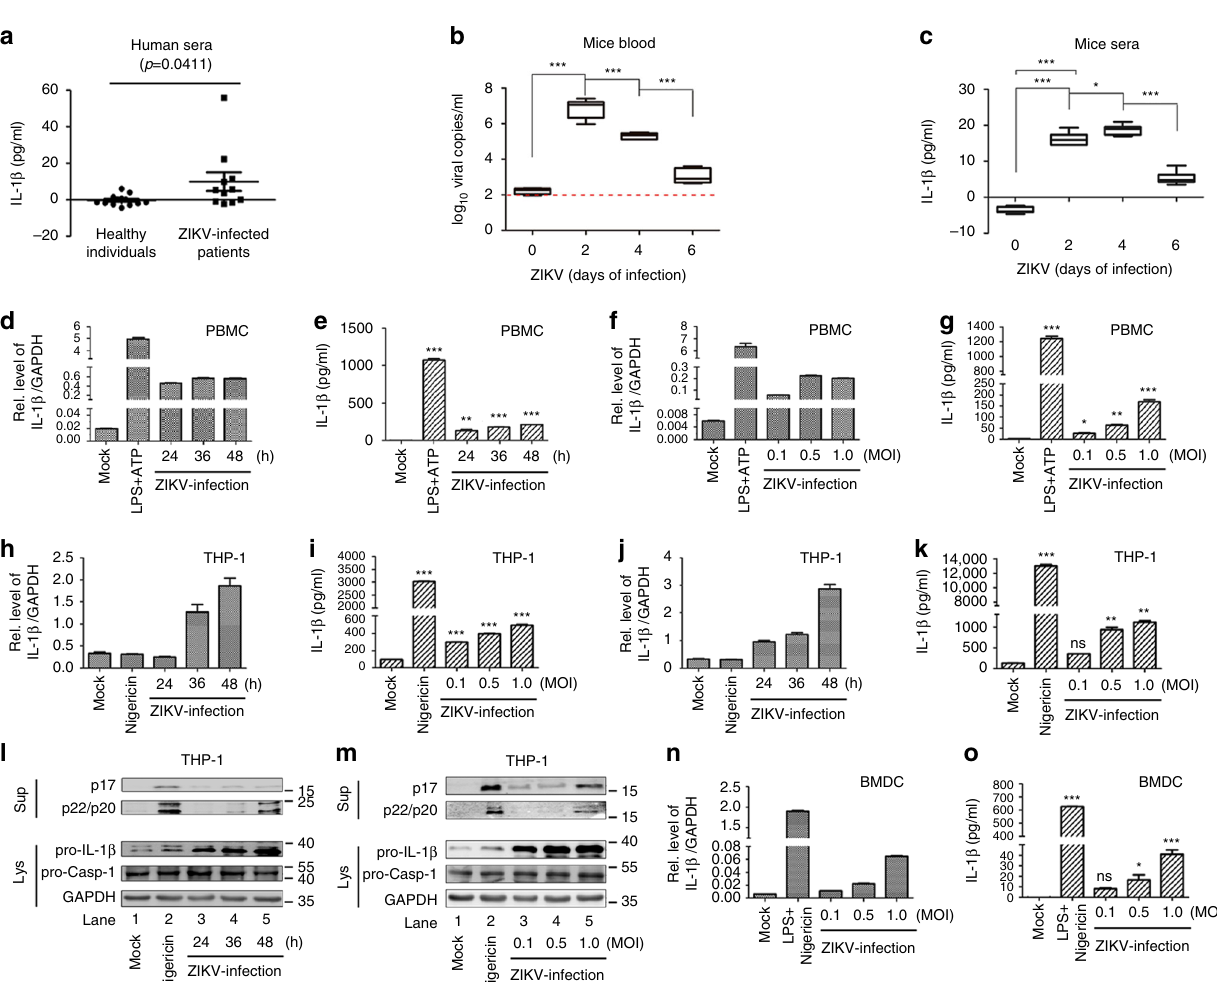
ZIKV proteins are involved in NLRP3 in fl ammasome activa- tion . The effects of ZIKV replication, proteins, and genomic RNA on the regulation of NLRP3 in fl ammasome were evaluated. In PBMCs, IL-1 β protein secretion and mRNA expression were induced by LPS and ZIKV but not by ultraviolet-inactivated (UV-inactivated) or heat-inactivated (heat-inactivated) ZIKV (Fig. 3a, b), and ZIKV RNA was detected in ZIKV-infected cells but not in cells treated with ATP or with UV- or heat-inactivated ZIKV (Fig. 3c). In THP-1-differentiated macrophages, IL-1 β secretion was stimulated by Nigericin and ZIKV but not by UV- or heat-inactivated ZIKV (Fig. 3d), IL-1 β mRNA was increased by ZIKV but not by Nigericin or UV- or heat-inactivated ZIKV (Fig. 3e), ZIKV RNA was detected in infected cells but not in cells treated with Nigericin or inoculated with UV- or heat-inactivated